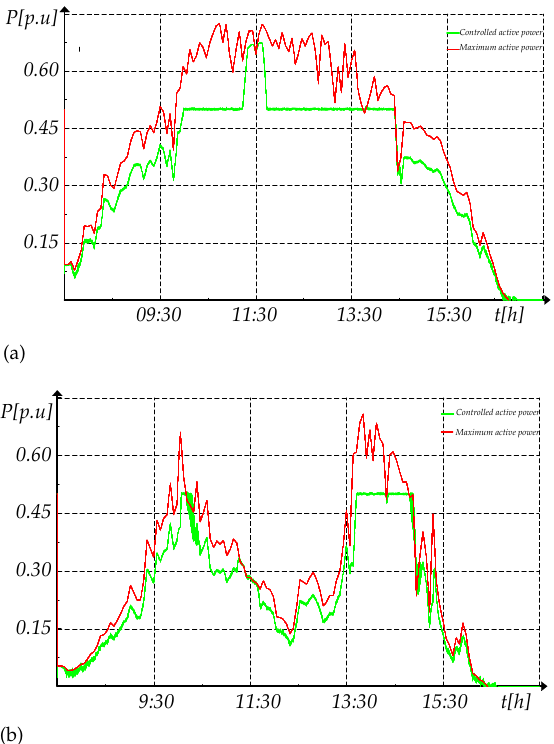
Figure 21. Control of active power for different power references. ( a ) Day one, ( b ) Day